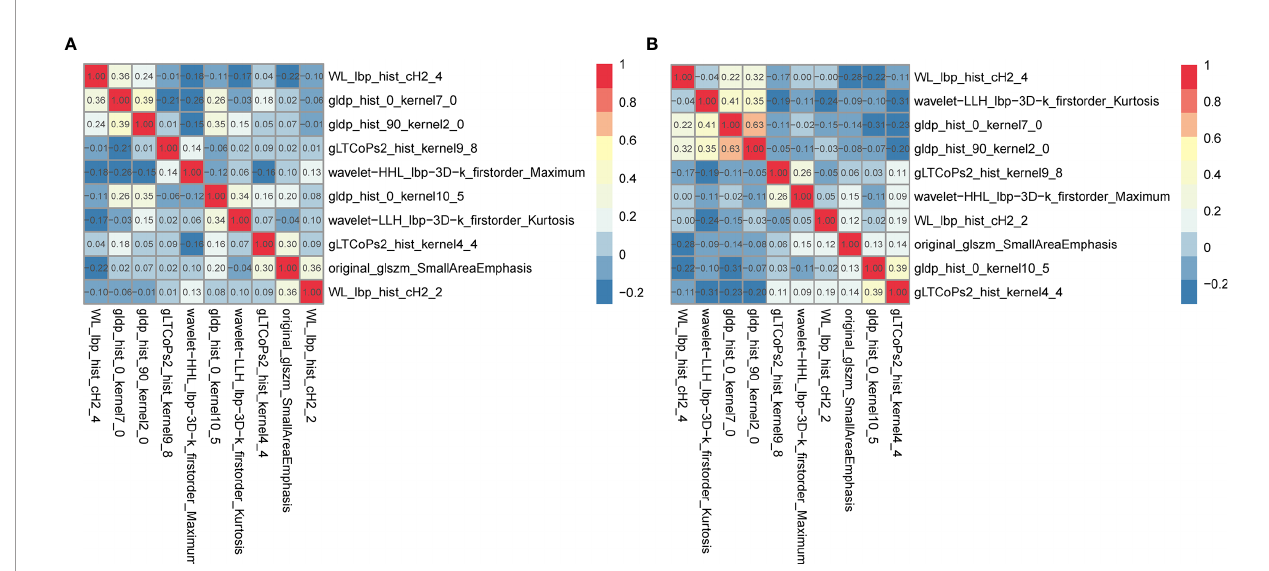
FIGURE 4 | Co-expression heat maps of radiomic features used to build the radiomic signature. (A, B) co-expression heat maps of the radiomic modeling features in the training cohort and validation cohort. Positive correlation represents co-expression relationships between radiomic features; and negative correlation represents negative co-expression relationships between features. Red indicates a positive correlation; blue indicates a negative correlation.